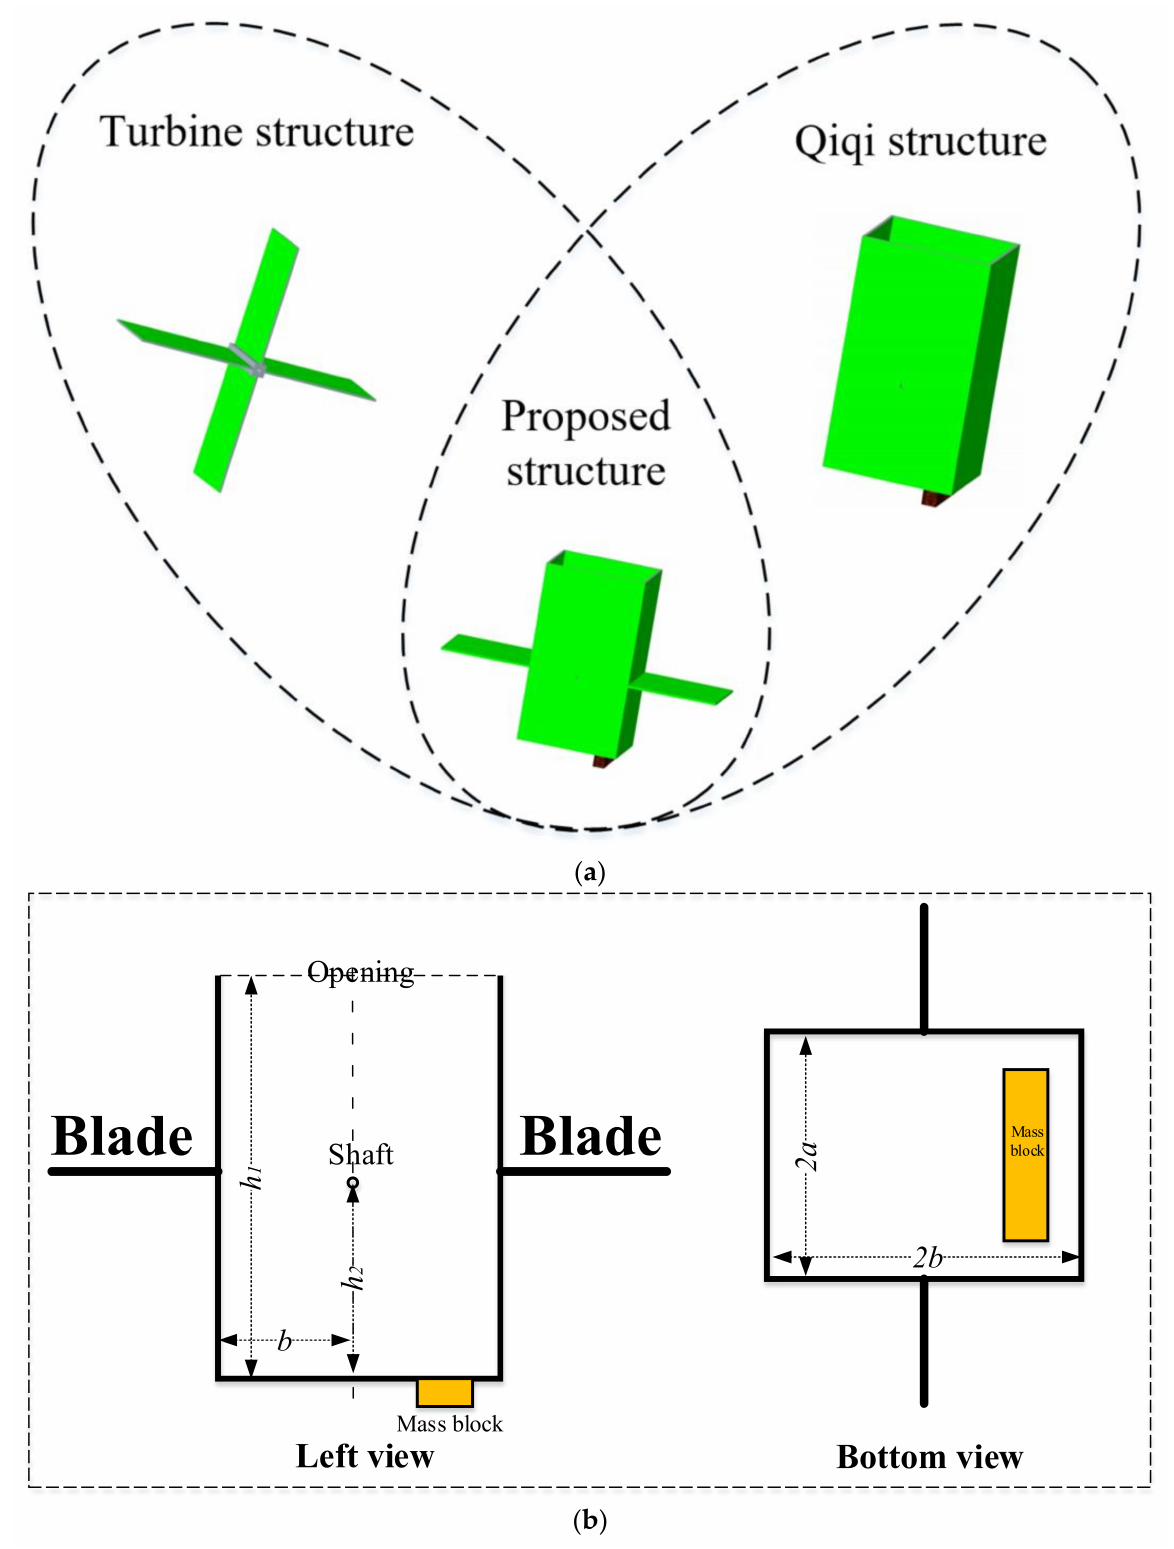
Figure 1. ( a ) 3D view of the investigated hybrid Qiqi structure; ( b ) 2D view of the hybrid